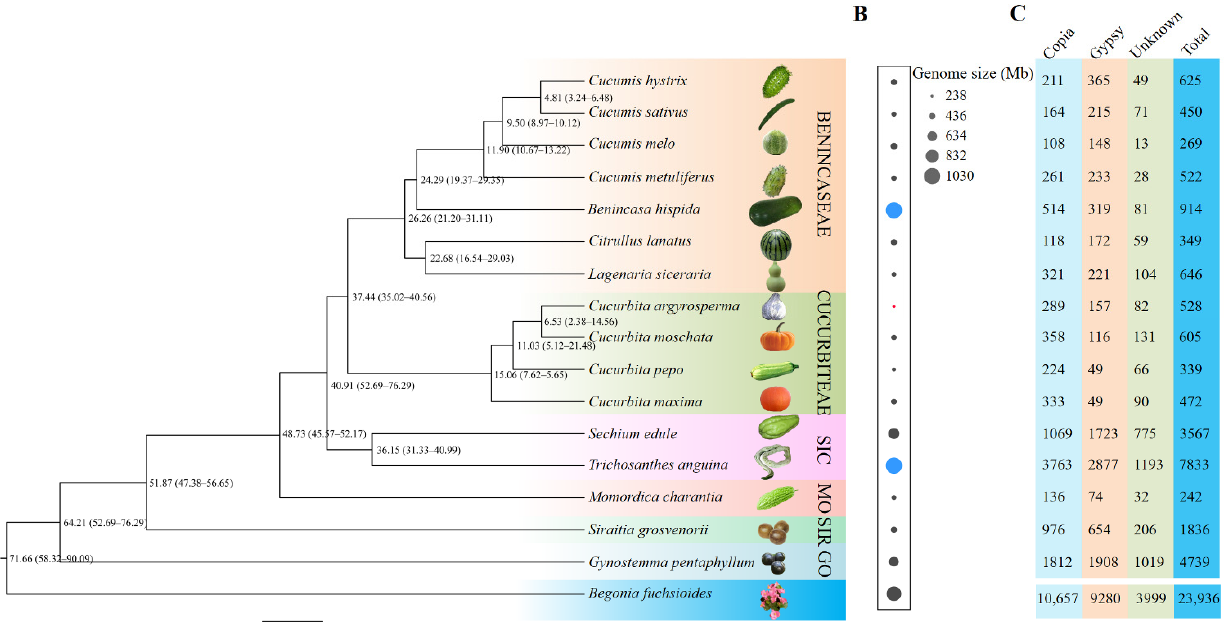
Figure 1. Phylogenetic analysis, genome size, and full-length LTR-RT numbers in Curcurbitaceae species. ( A ) Phylogenetic tree and divergence time. Begonia fuchsioides is used as an outgroup. Numbers on the nodes indicate the average divergence time of the common ancestor (MYA). The number ranges in the brackets represent the 95% confidence intervals of the estimated divergence time. Names of six tribes are noted at the right, and four of them are abbreviated: SIC, Sicyoeae; MO, Momordiceae; SIR, Siraitieae; GO, Gomphogyneae. ( B ) Genome size of the studied species. Red and blue dots indicate the smallest ( Cucurbita argyrosperma , 238 Mb) and the largest genomes ( Benincasa hispida and Trichosanthes anguina , 1030 Mb), respectively. ( C ) Number of full-length LTR-RTs detected in the 16 Curcurbitaceae species. The bottom row of numbers summarizes the total number of Copia, Gypsy, Unknown, and all LTR-RTs in the 16 Curcurbitaceae